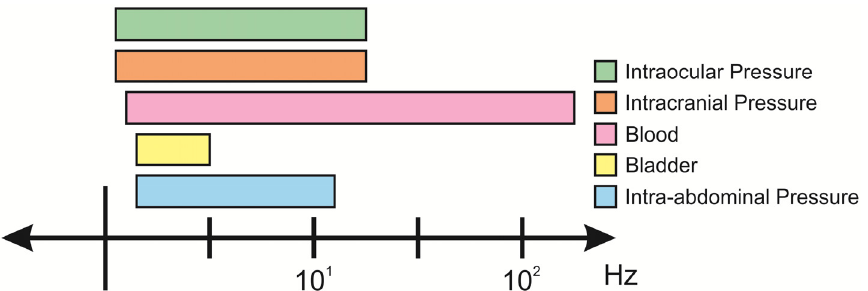
Figure 4. Relevant frequency bandwidths for varying pressure signals in vivo